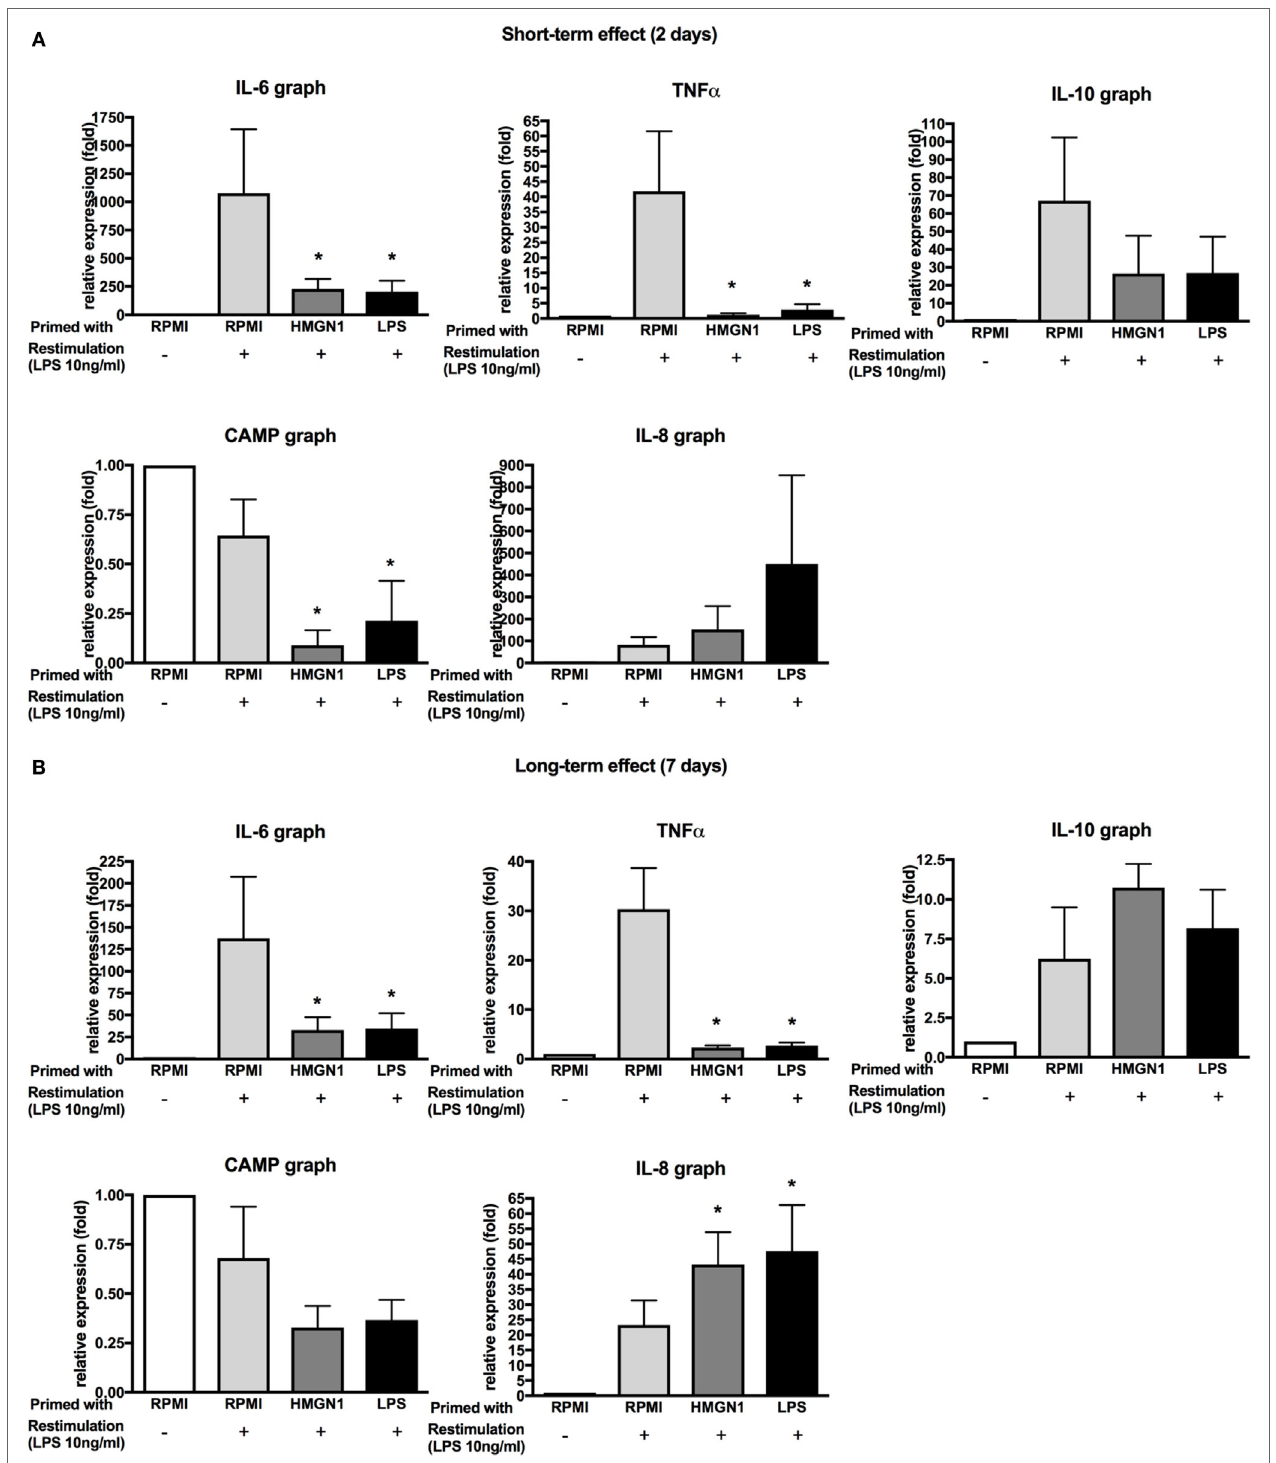
FigUre 5 | Effect of high-mobility group nucleosome-binding protein 1 (HMGN1) on TNF, IL-6, IL-8, IL-10, and CAMP production. Human peripheral blood mononuclear cells were primed with recombinant HMGN1 or lipopolysaccharide (LPS) for 24 h and then washed with PBS. The cells were further rested in RPMI containing 10% serum for (a) 24 h or (B) 7 days. The cells were stimulated with LPS or RPMI. The total RNA was extracted after 4 h and the different gene expression was measured by RT-PCR. The expression fold of target genes was normalized to the expression of HPRT [ n = 5–6, * p < 0.05 vs RPMI (LPS restimulated)